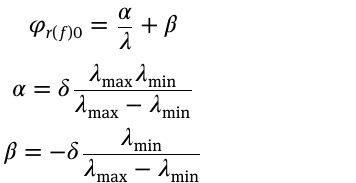
= 2 mm, b = 9 mm, unit 2 with a = 2 mm, 1 1 2 when 2